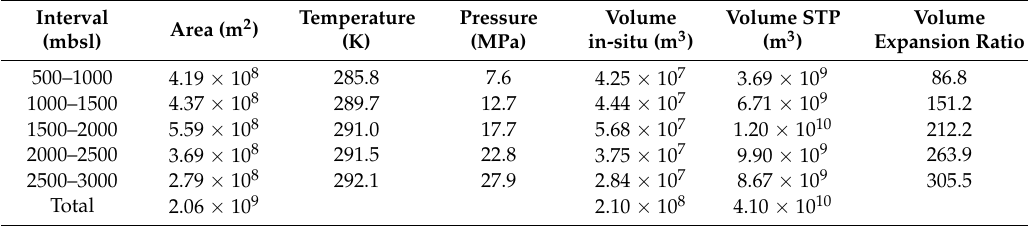
Table 1. Free gas volume at in-situ and STP